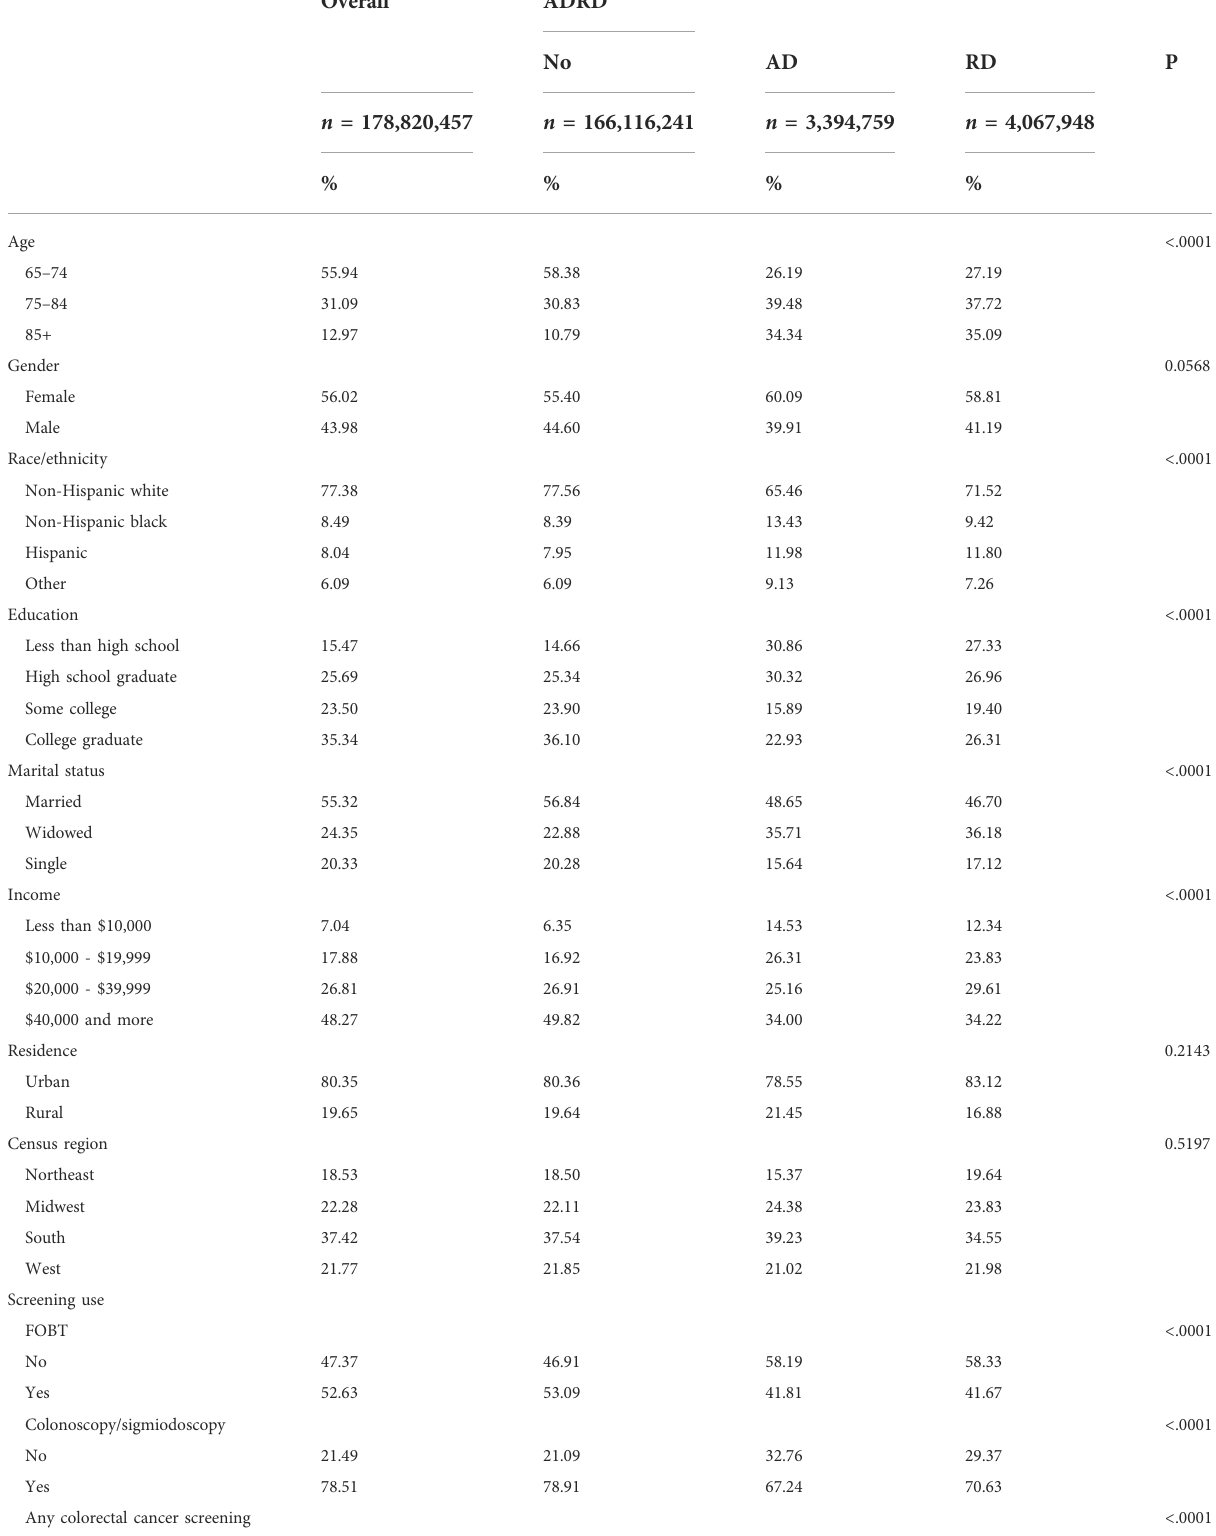
TABLE 1 Characteristics of older adults without colorectal